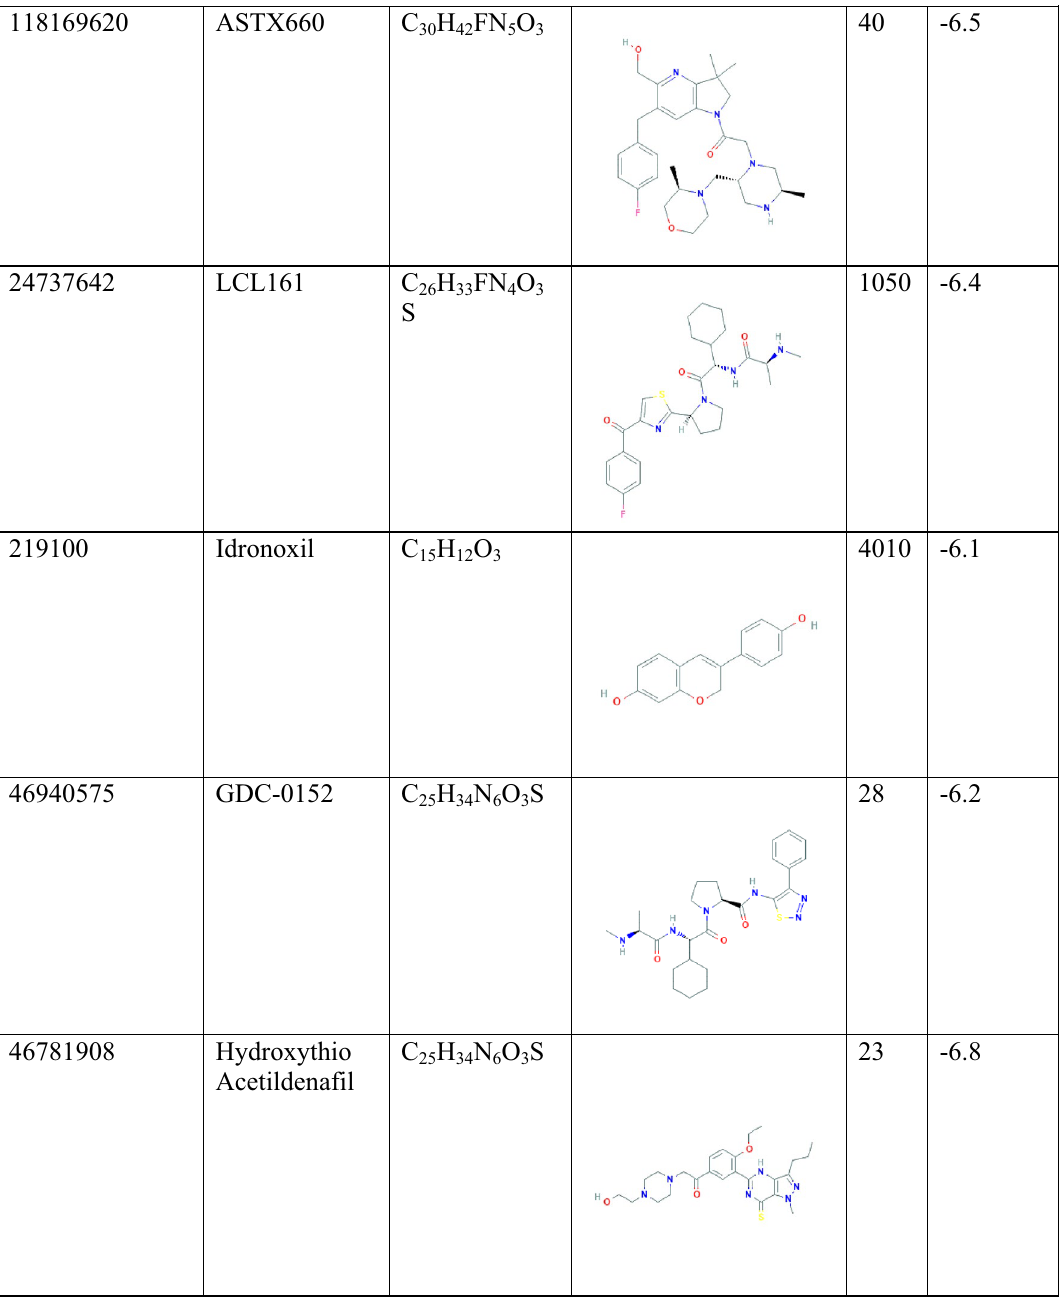
Table 1. List of 10 known active antagonist of XIAP protein and their binding affinity towards the protein generated through molecular docking